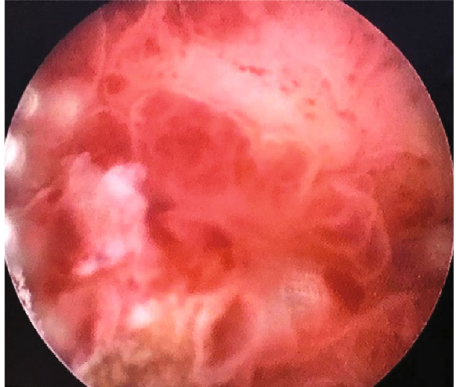
Figure 2: Macroscopic aspect of a bullous lesion of the bladder with a grape-like aspect.